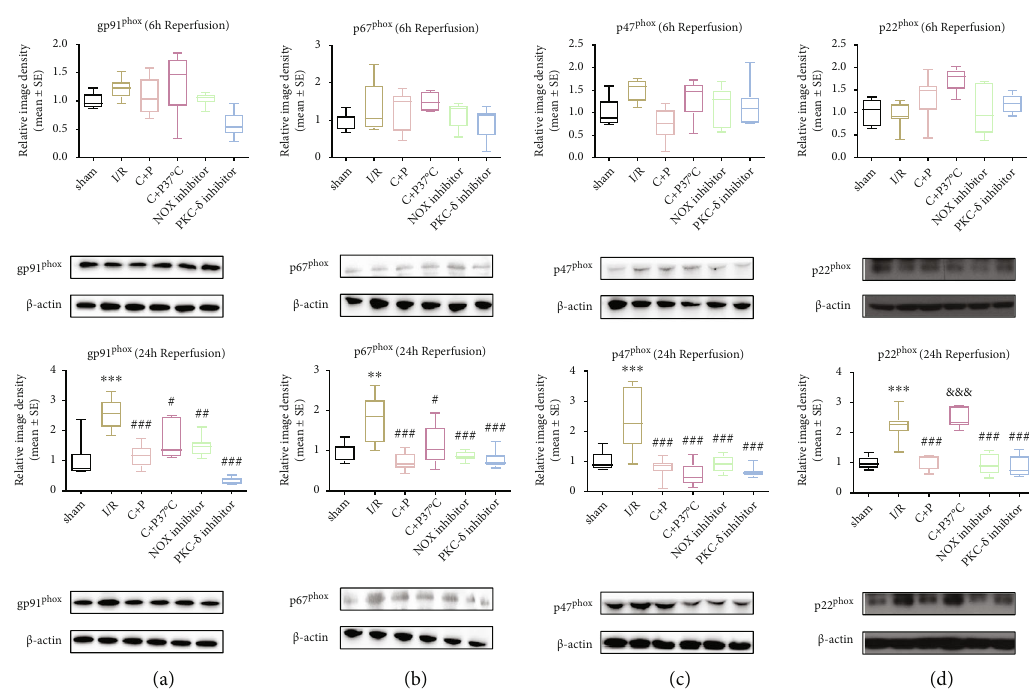
Figure 3: C+P decreased NOX subunit protein levels after stroke in ischemic brain tissue. (a) gp91 phox , (b) p67 phox , (c) p47 phox , and (d) p22 phox assessed via the Western blot technique at 6 and 24 hours of reperfusion. Levels of gp91 phox , p67 phox , p47 phox , and p22 phox rose after I/R but decreased after C+P treatment and administration of the PKC- δ or NOX inhibitor at 24 hours of reperfusion, with the exception of p22 phox in the C+P at the 37 ° C group at 24 hours of reperfusion. There was a larger decrease in p22 phox expression in the non-temperature-controlled C+P versus the temperature-controlled C+P group at 24 hours of reperfusion ( n = 7 ). ∗∗ p < 0 : 01 and ∗∗∗ p < 0 : 001 versus the sham group; # p < 0 : 05 , ## p < 0 : 01 , and ### p < 0 : 001 versus the I/R group; &&& p < 0 : 001 versus the C+P group. Results are shown as mean ± SE . The representative immunoblots are